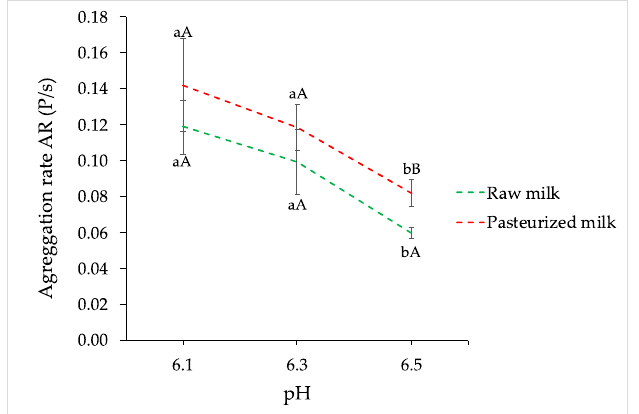
Figure 6. Influence of pH and heat treatment of milk on aggregation rate AR (Pa/s). Values with different lowercase letters (a, b) represent differences between the pH levels of the same milk, different uppercase letters (A, B) represent differences between milk heat treatments (raw/pasteurized). Comparison of means was performed by LSD test ( p < 0.05).